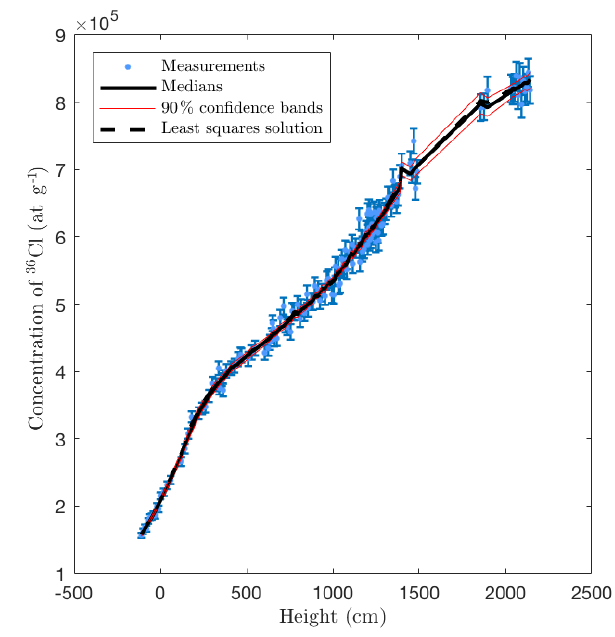
Figure 3. Measured and sampled 36 Cl concentrations for the syn- thetic case with 146 36 Cl